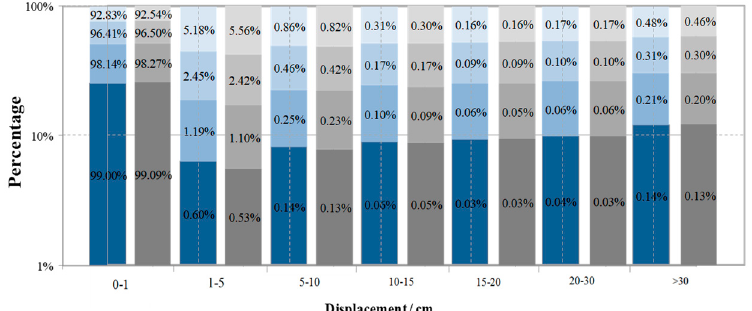
Figure 5. The area percentage of the displacement triggered by the Haiyuan/Liupanshan Fault at different magnitudes; the grey gradual change bar is the area percentage of the displacement associated with the y-axis, triggered by the Haiyuan Fault at the seismic scenario, and the blue gradual change bar is the area percentage of the displacement associated with the y-axis, triggered by the Liupanshan Fault at the seismic scenario).